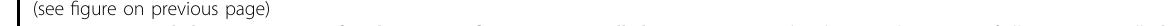
Fig. 3 Functional characterization of cachexia-speci fi c progenitor cell clusters. a UMAP plot showing the origins of all progenitor cells. b Dot plot showing the enriched biological processes among downregulated genes in vPreAl from patients with cachexia. c Volcano plot showing the differences in the expression of genes involved in fat cell differentiation in vPreA. Red dots denoting genes signi fi cantly upregulated in VAT from patients with cachexia, and blue dots denoting genes down-regulated from patients without cachexia. d Boxplot showing the proportion of progenitor cells derived from patients with ( n = 4) or without ( n = 4) CAC for each cell population. e Bar plot showing signi fi cantly enriched KEGG pathways in DEGs between in fl ammatory progenitor cell and the other progenitor cells in SAT. The color saturation of bars indicating the signi fi cance of enrichment. P -values were adjusted by the FDR. f Relative mRNA expression levels of CCL2 , CXCL2 , and TNFAIP6 in white preadipocytes in each group as quanti fi ed by qPCR analyses. P -values were determined by the two-way ANOVA with post hoc Dunnett ’ s multiple-comparison tests. * P < 0.05; *** P < 0.001 ( n = 3 biological replicates). Values are means ±